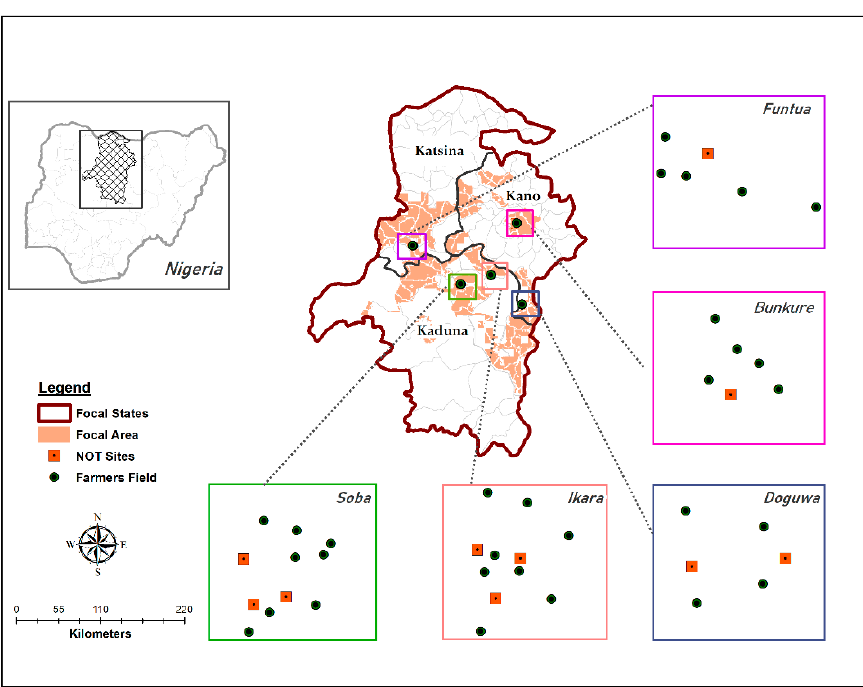
Figure 1. Map showing the multiple locations of the farmers’ fields and nutrient omission trials (NOTs) that were covered by unmanned air vehicle (UAV) flight missions and included in this study.